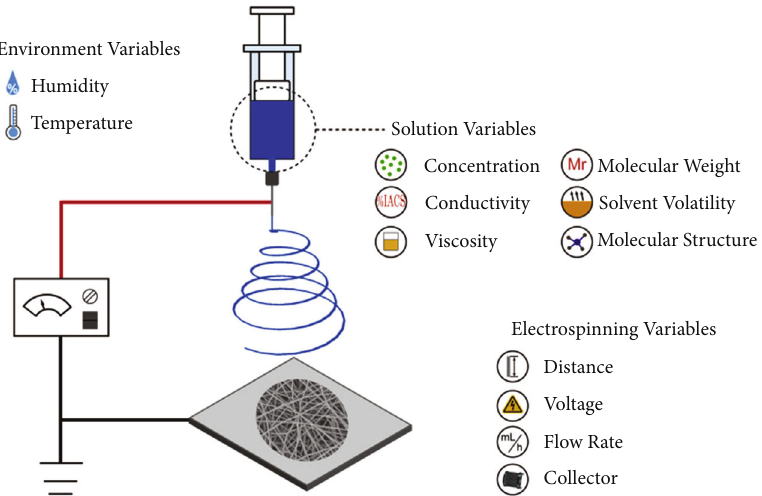
Figure 5: Schematic of a conventional electrospinning setup, as well as environment, solution, and electrospinning